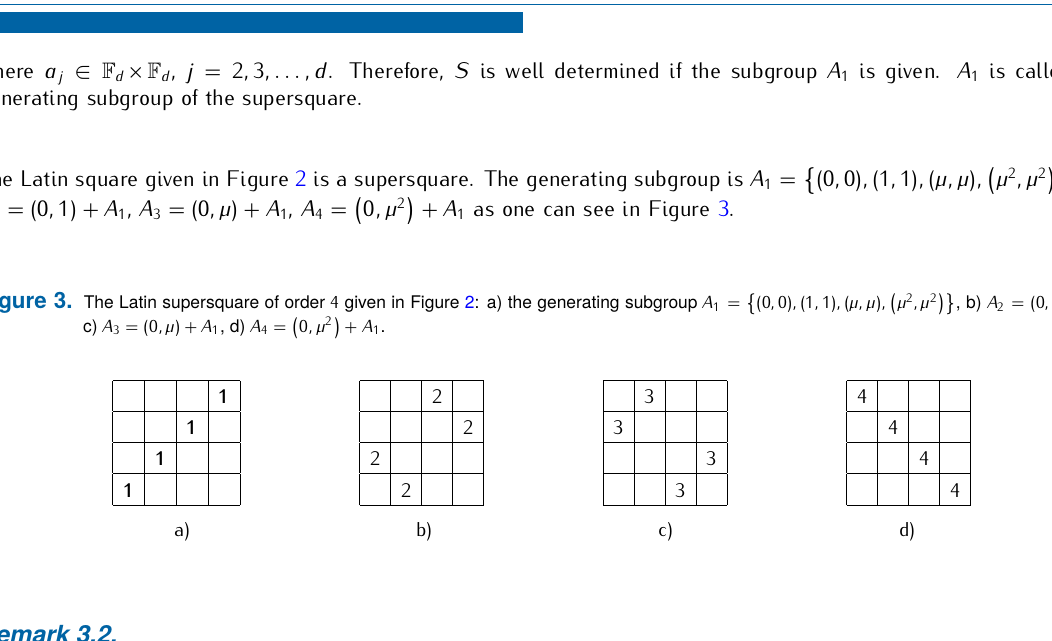
(cid:8) (0 , 0) , (1 , 1) , ( µ,µ ) ,